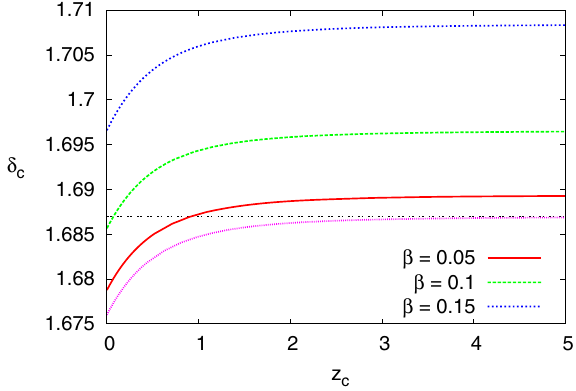
Fig. 6 Extrapolated linear density contrast at collapse for coupled quintessence models with different coupling strength β . For all plots we use a constant α = 0 . 1. We also depict δ c for reference Λ CDM (dotted, pink) and EdS (double-dashed, black) models. Image reproduced by permission from Wintergerst and Pettorino (2010); copyright by